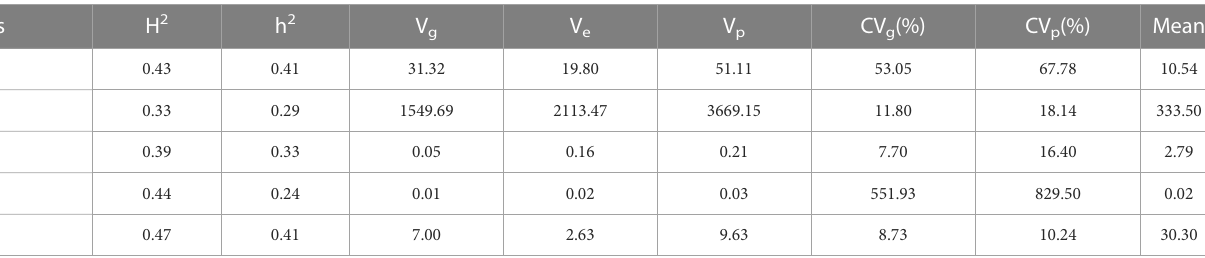
TABLE 1 Genetic parameter estimates in white Guinea yam farmer landraces.